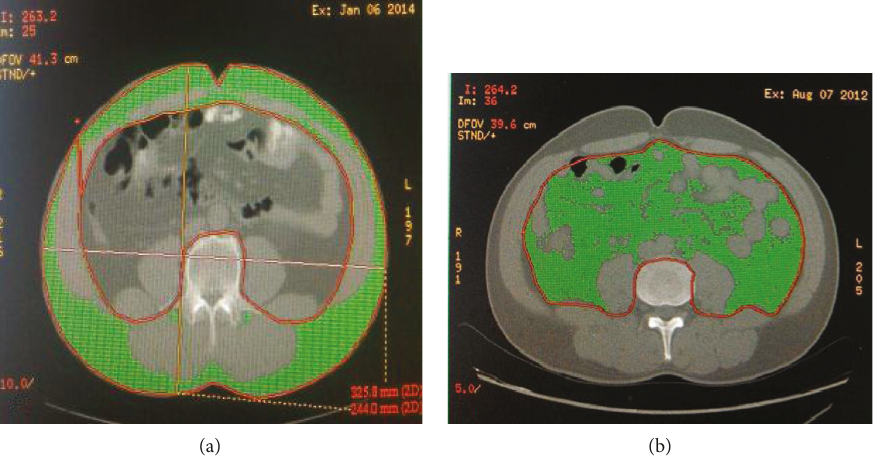
Figure 2: Images demonstrating the method used to determine abdominal fat, distribution on a CT scan obtained at the navel level: (a) the green area represents subcutaneous fat; (b) the green area represents visceral fat